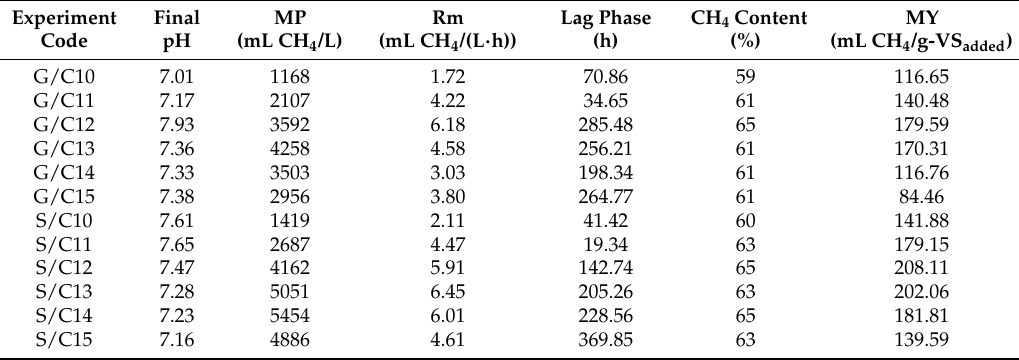
Table 5. Methane production (MP), methane content, methane production rate (Rm) and methane yield (MY) from a co-digestion of Napier grass with cow dung and silage with cow dung by bioaugmentation with anaerobic